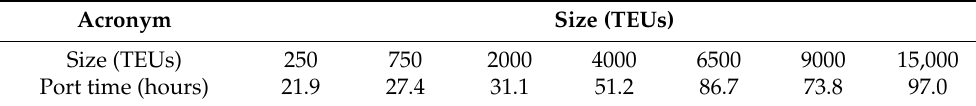
Table 3. Port time (TP(SS)) as function of ship size (TEUs).